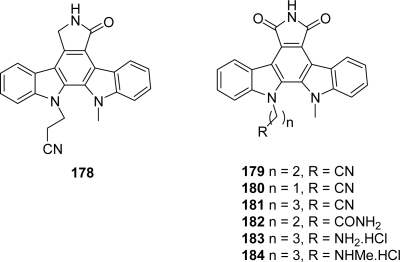
Rebeccamycin analogues substituted on the indole nitrogens.